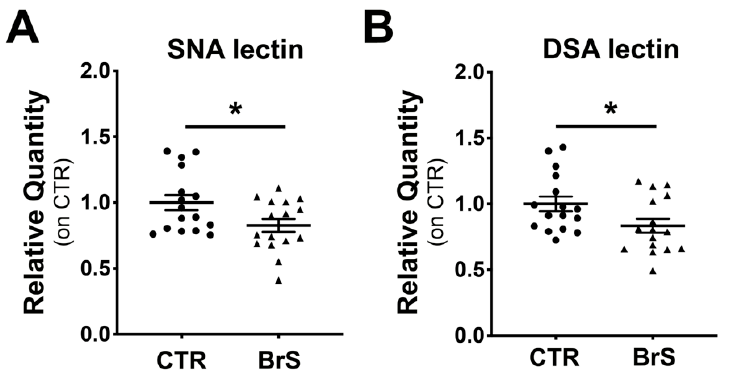
Figure 3. PBMCs intracellular proteins are differentially sialylated in BrS patients. Sialylation and desialylation status of the intracellular PBMCs protein was analyzed through Western blot followed by incubation with SNA and DSA lectins, respectively. ( A ) Total intracellular sialylation levels. ( B ) Total intracellular desialylation levels. Data represent the mean ± SEM and are expressed as relative amounts compared with healthy controls. Each dot and triangles in the graphs represent a single healthy control and a single BrS patient, respectively. Statistical significance was determined by Student’s t -test or Mann–Whitney, based on the normal distribution of data. CTR: N = 16, BrS: N = 16. * p < 0.05.